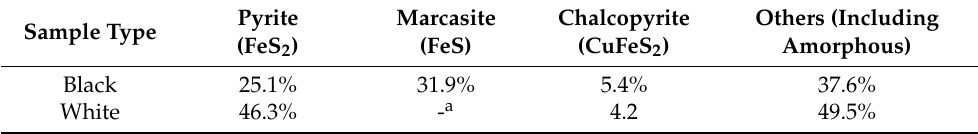
Table 5. Mineral composition of two types of